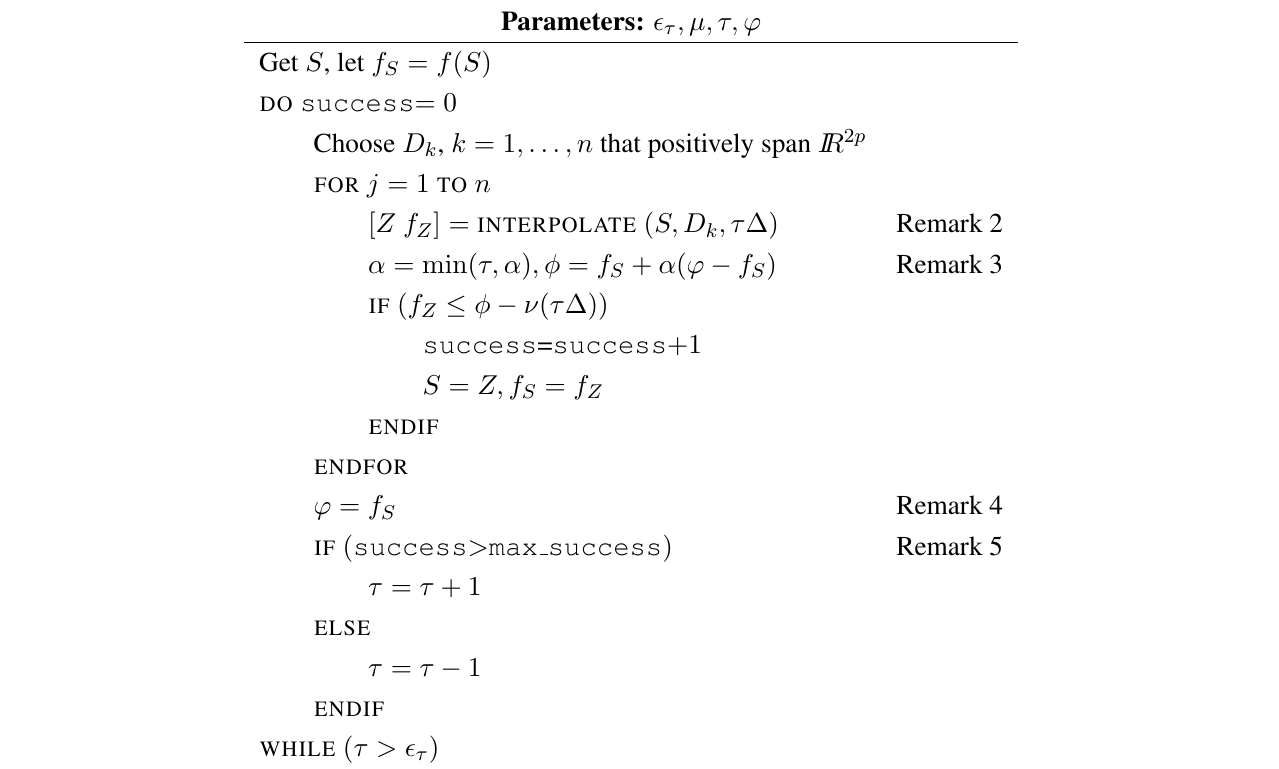
Table 1. Non-monotone derivative-free